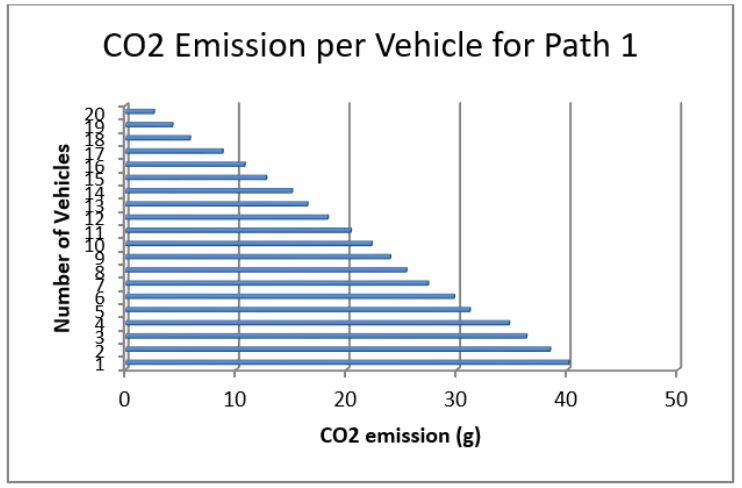
Figure 6. CO2 emission for each vehicle for t2=60 seconds